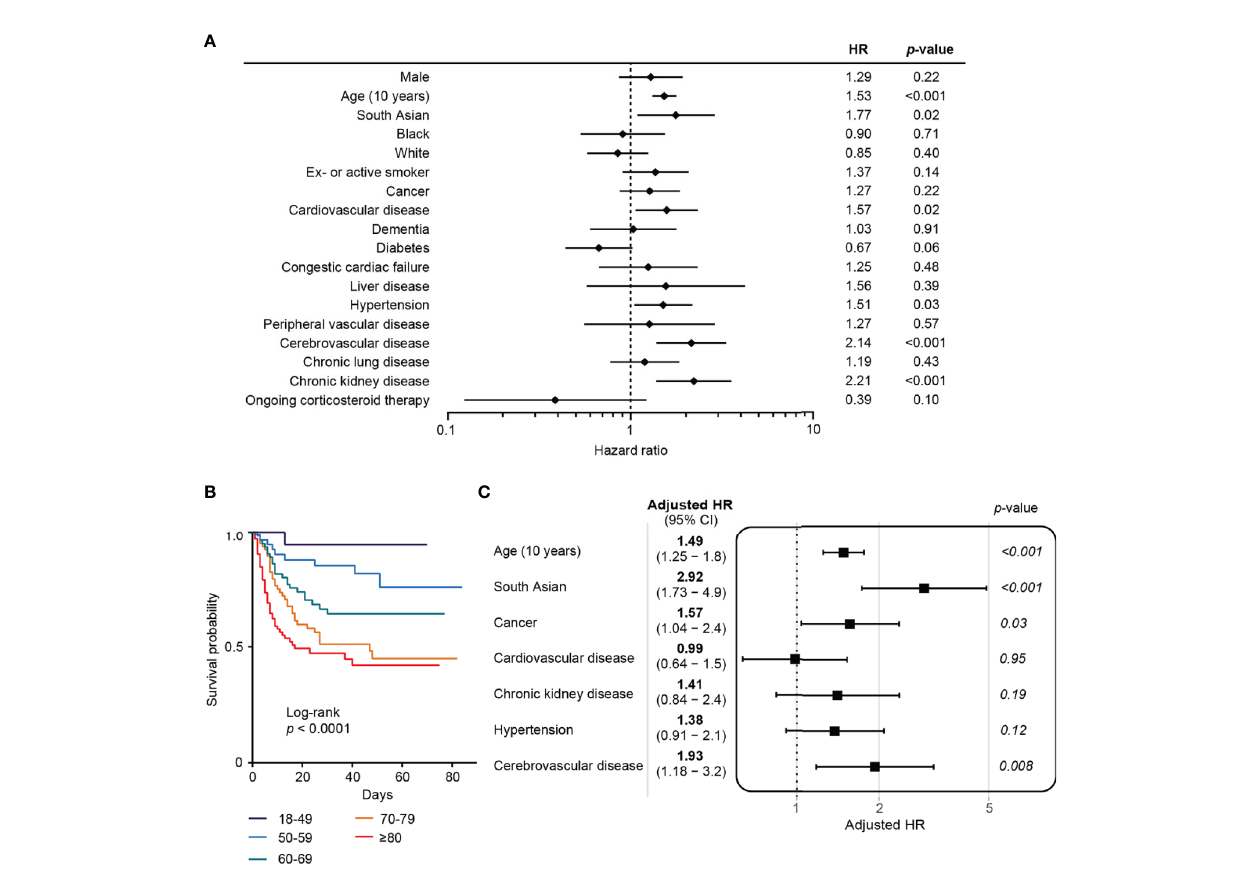
FIGURE 2 | Risk factors for COVID-19 mortality in combined cancer and non-cancer cohorts. (A) Forest plot showing the hazard ratios from univariate analysis of risk factors associated with mortality in COVID-19. Horizontal bars indicate 95% CI. HR, hazard ratio. (B) Kaplan – Meier plot of survival analysis by age. (C) Multivariate analysis of risk factors associated with mortality following